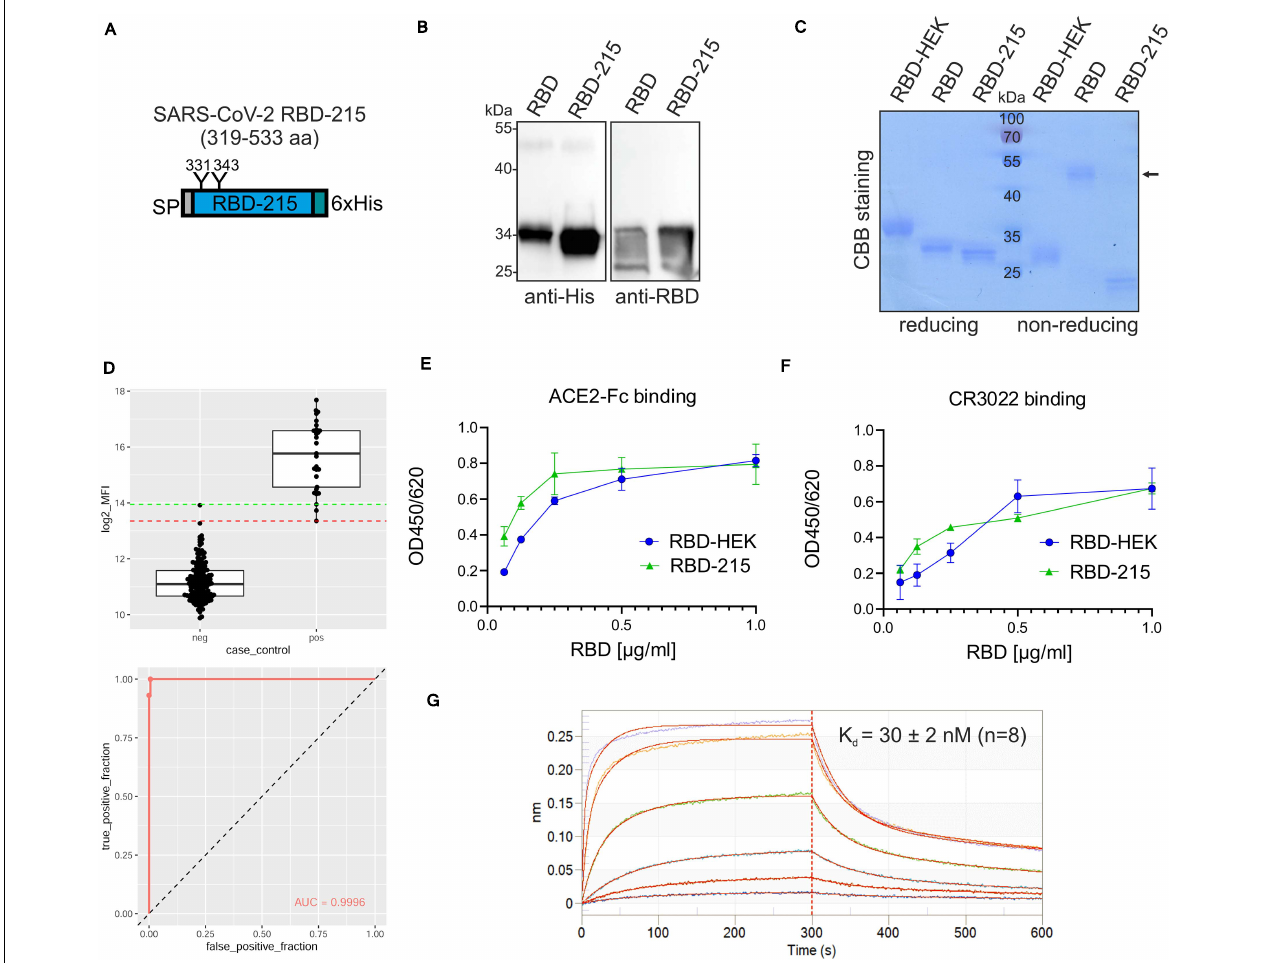
FIGURE 4 | A plant-produced truncated RBD variant is functional. (A) Schematic illustration of the truncated RBD-215 variant. (B) Comparison of RBD and RBD-215 protein expression in leaf extracts of (cid:49) XT/FT Nicotiana benthamiana analyzed by immunoblotting 4 days after infiltration. (C) RBD variants were purified from the apoplastic fluid 4 days after infiltration, analyzed by SDS-PAGE under reducing or non-reducing conditions, followed by Coomassie Brilliant Blue (CBB) staining. HEK293-produced RBD (RBD-HEK) was included for comparison. The altered mobility of RBD-HEK and the plant produced RBD variant is caused by differences in complex N-glycans. The arrow marks the position of the homodimer. (D) Binding of sera from healthy blood donors collected prior to 2018 (neg, n = 163) and sera from SARS-CoV-2 exposed individuals (pos, n = 26) to plant-produced RBD-215. Binding was analyzed using a Luminex bead-based assay and the median fluorescent intensity (log2 MFI) is shown. The lines indicating the 100% sensitivity cut-off (red) and the 100% specificity cut-off (green) as well as the receiver operating characteristic (ROC) curve and the area under the curve (AUC) are shown. (E) Binding of purified plant-produced RBD-215 and RBD-HEK to plates coated with ACE2-Fc or (F) antibody CR3022. Data are presented as mean ± SD ( n = 3). (G) BLI analysis. Binding kinetics of the interaction between biotinylated mAb CR3022 loaded on SAX biosensors and RBD-215 at a concentration range of 1.2–300 nM. Representative real-time association and dissociation curves are